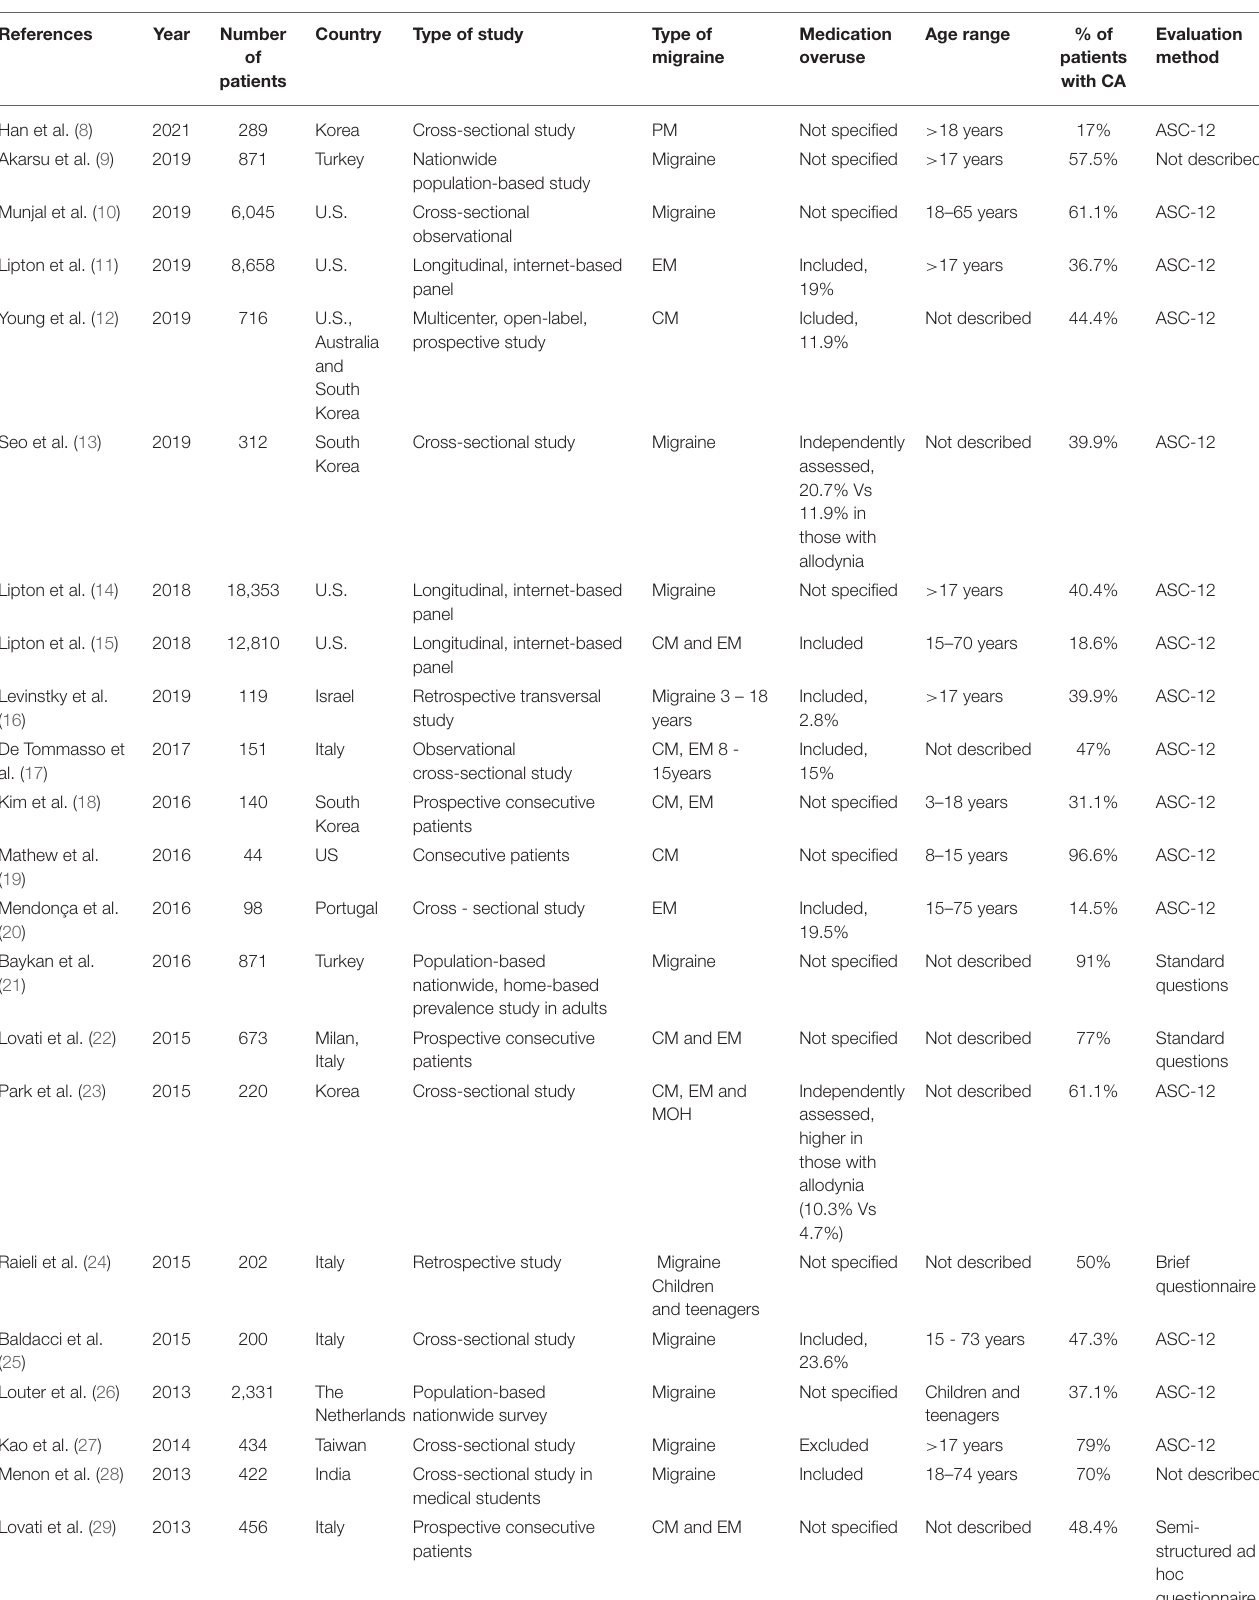
TABLE 1 | Most relevant studies regarding different epidemiological aspects of CA in